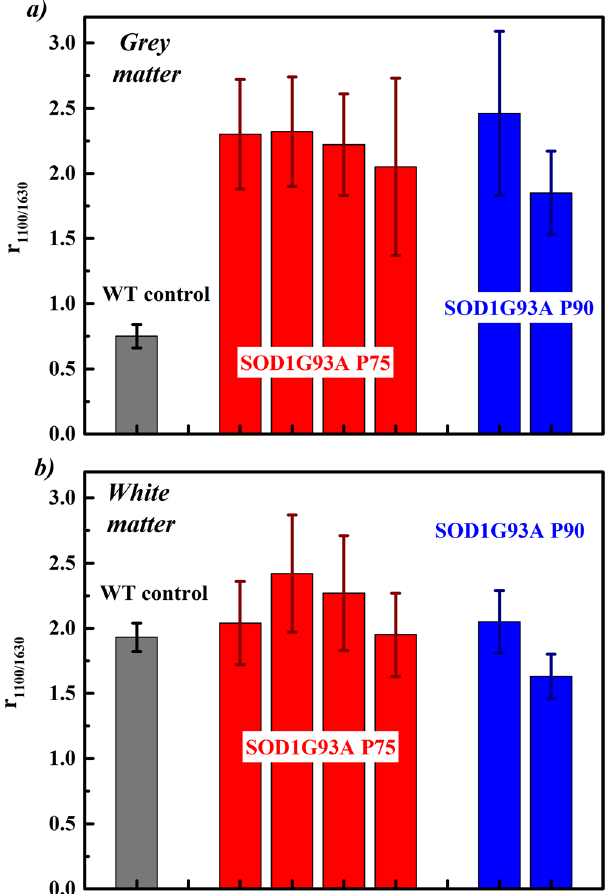
Figure 4. Histogram reporting the Raman signal intensity ratio between the spectral envelopes centred at 1100 cm − 1 and at 1630 cm − 1 for the analysed spinal cord sections of WT control mice and of SODG93A P75 and P90 models. The mean value and standard deviation reported for the WT control were obtained considering all the spectra recorded from the spinal cord sections of five mice. For the SOD1G93A models, each column is relative to a different specimen. Panel (a) is relative to grey matter regions in the ventral horns. Panel (b) is for white matter regions of the same spinal cord sections as in (a)